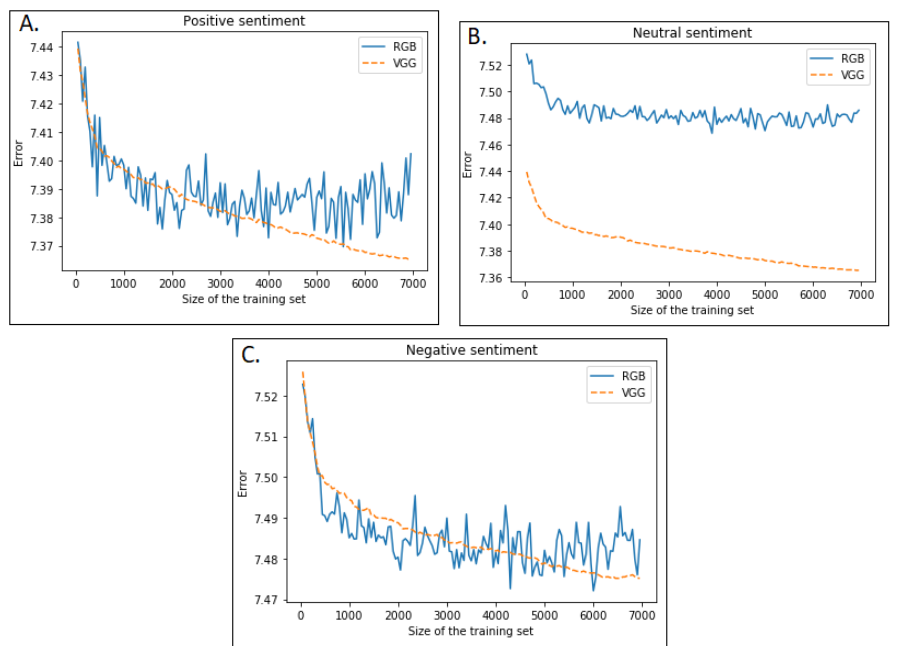
Figure 4. Mean errors and standard deviation for different sizes of the training set for T4SA data set. Comparison between RGB pixel-value features and the VGG16 features. ( A )—positive sentiment category, ( B )—neutral sentiment category, ( C )—negative sentiment category.